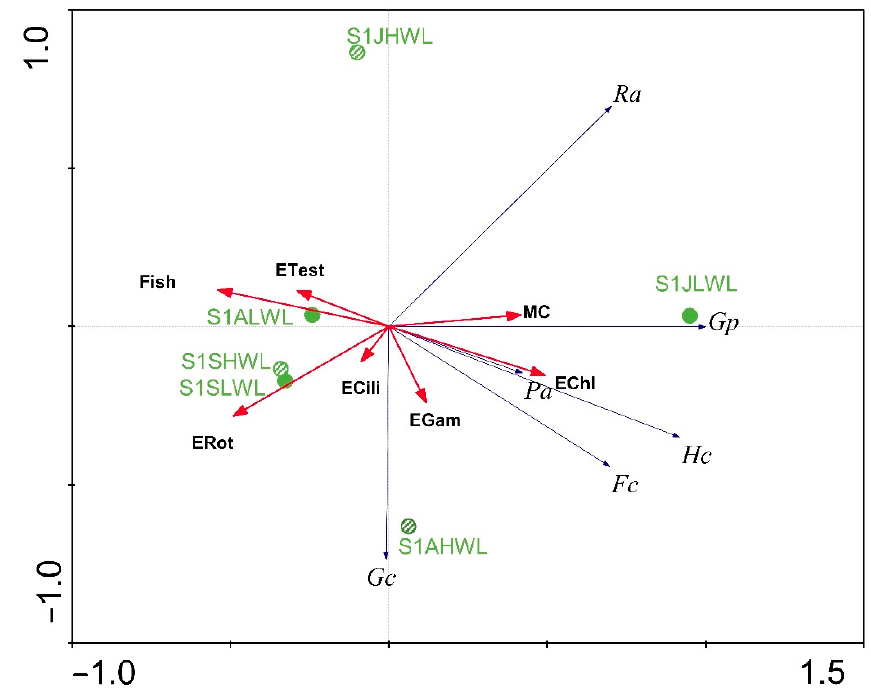
Figure 7. RDA-plot illustrating relationships among sampling sites, physicochemical variables, and gastropod abundance within the macrophyte stands at S1. Abbreviations are provided in Materials and Methods.